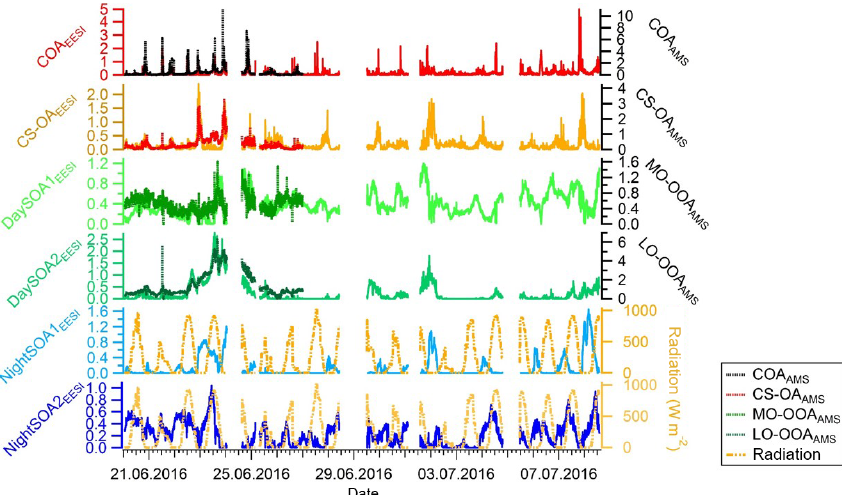
Figure 3. Time series of EESI-TOF-MS PMF factors (ags − 1 ) on the left axis and related AMS PMF factors, when applicable, on the right axis (µgm − 3 ) for the overlapping measurement period. Solar radiation measurements (Wm − 2 ) from the NABEL station are reported as well for comparison with the night-time EESI factors time